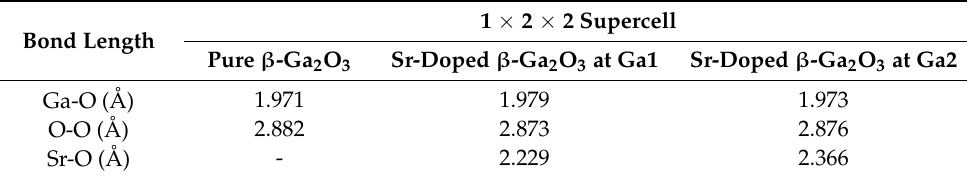
Table 4. Calculated average bond length of pure β -Ga 2 O 3 and Sr-doped β -Ga 2 O 3 for 1 × 2 × 2 unit cell.